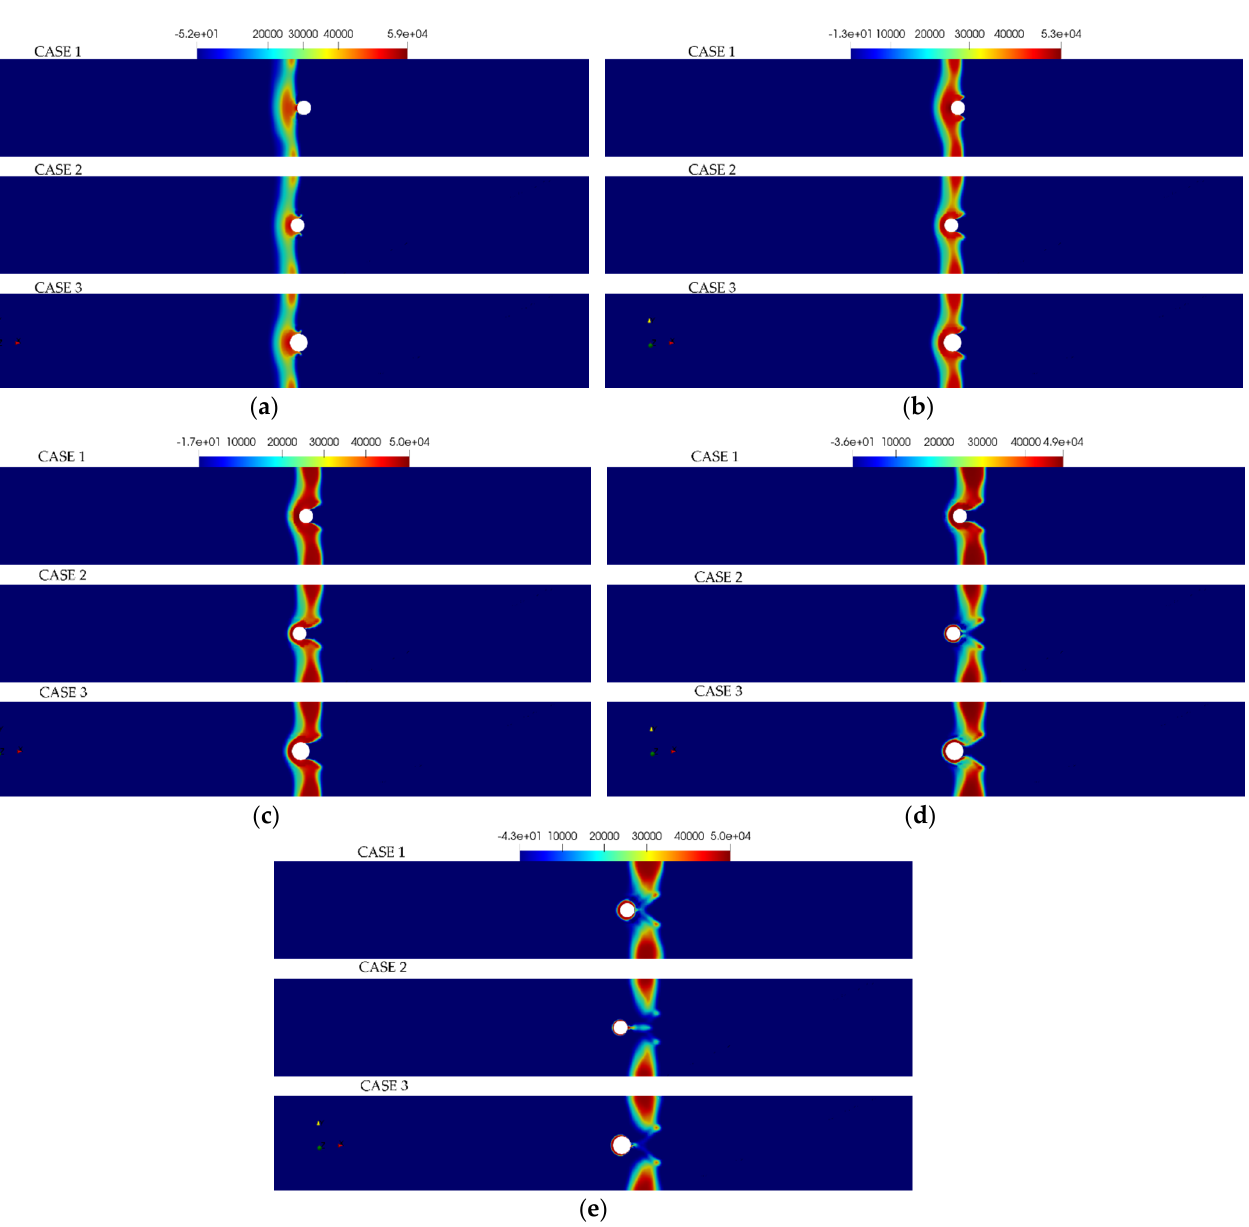
Figure 14. Comparison of the pressure distribution for different substructures at various time steps for: ( a ) t = 31.2 s, ( b ) t = 31.3 s, ( c ) t = 31.4 s, ( d ) t = 31.5 s, and ( e ) t = 31.6 s.